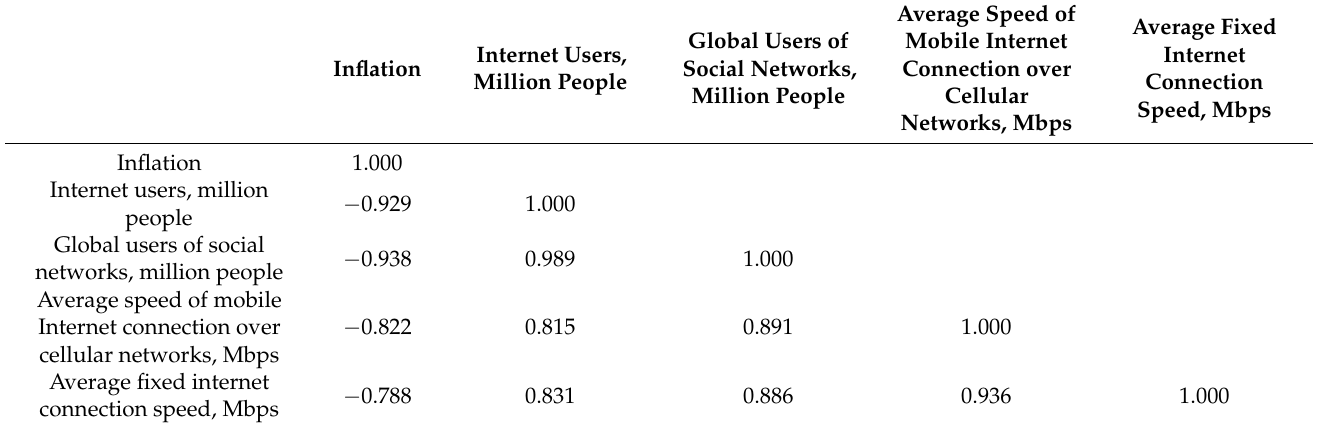
Table 10. Results of correlation analysis of inflation and factors of information integration.